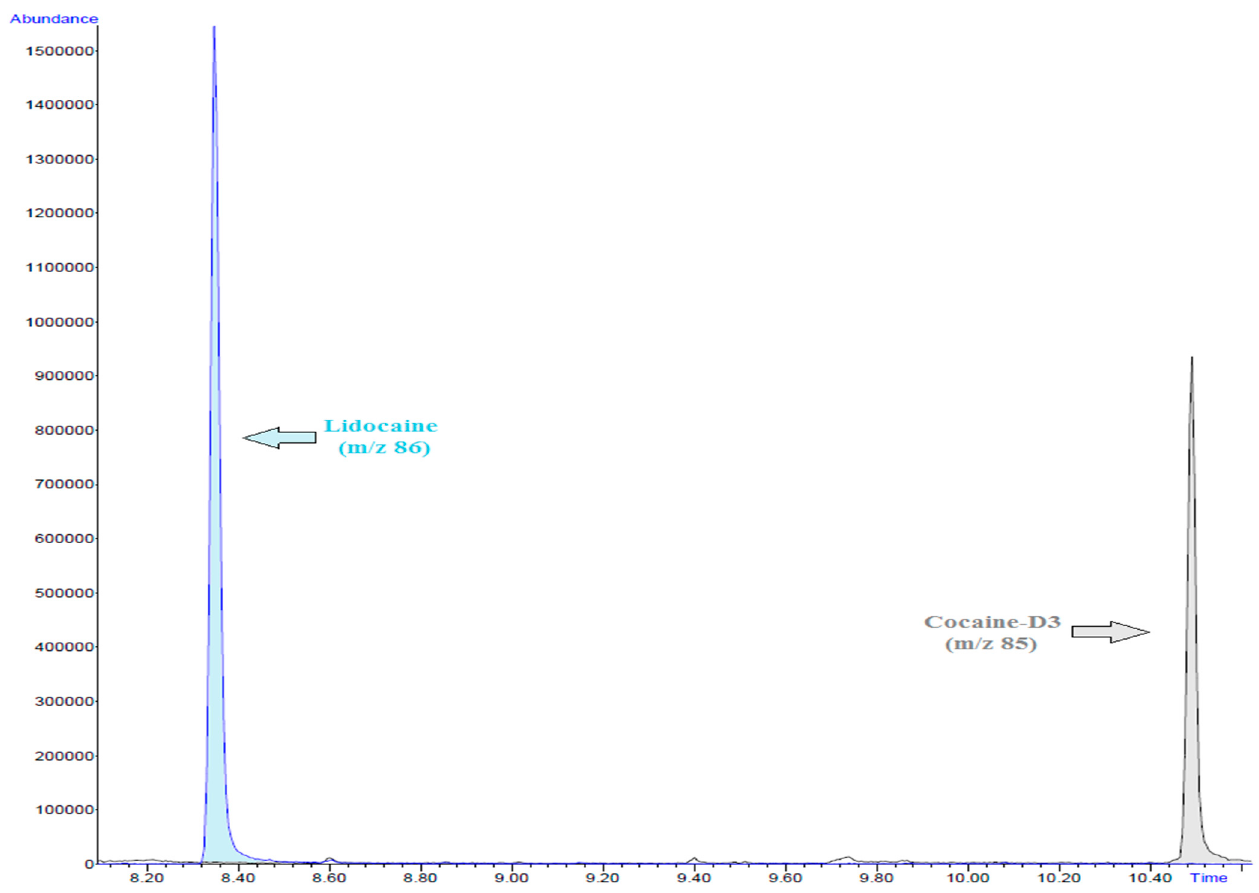
Figure 2. Extracted ion chromatograms for lidocaine and cocaine-D3.